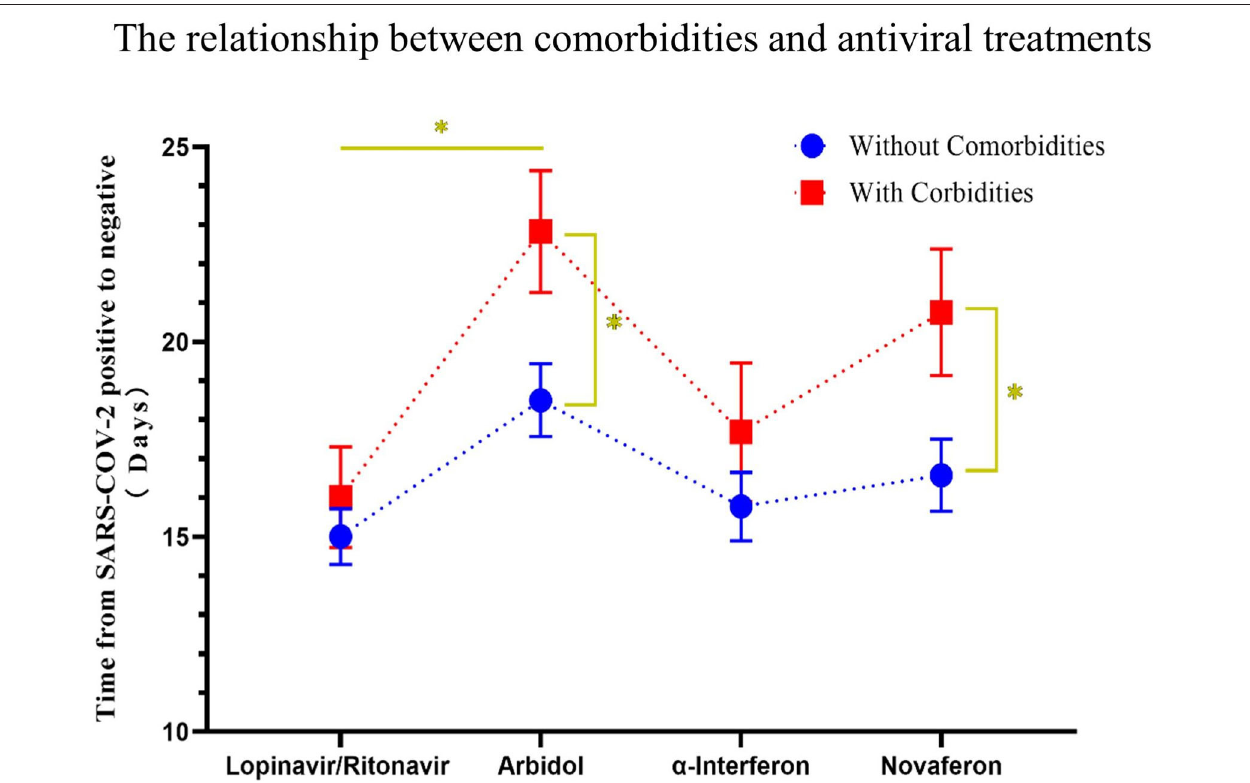
FIGURE 5 | The relationship between comorbidities and the conversion time from real-time PCR (rtPCR) positive to negative during antiviral treatment. Patients were divided by different used antiviral drugs, and the conversion time from rtPCR positive to negative of patients with or without comorbidities was compared. Patients with comorbidities had a longer time of rtPCR conversion than patients without comorbidities throughout antiviral drug treatment. Data are presented as mean ± SEM. The significance was determined as * p < 0.05.